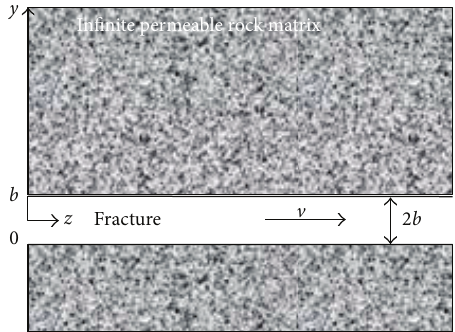
Figure 2: Geometry of the model with a single, planar, infinite frac-